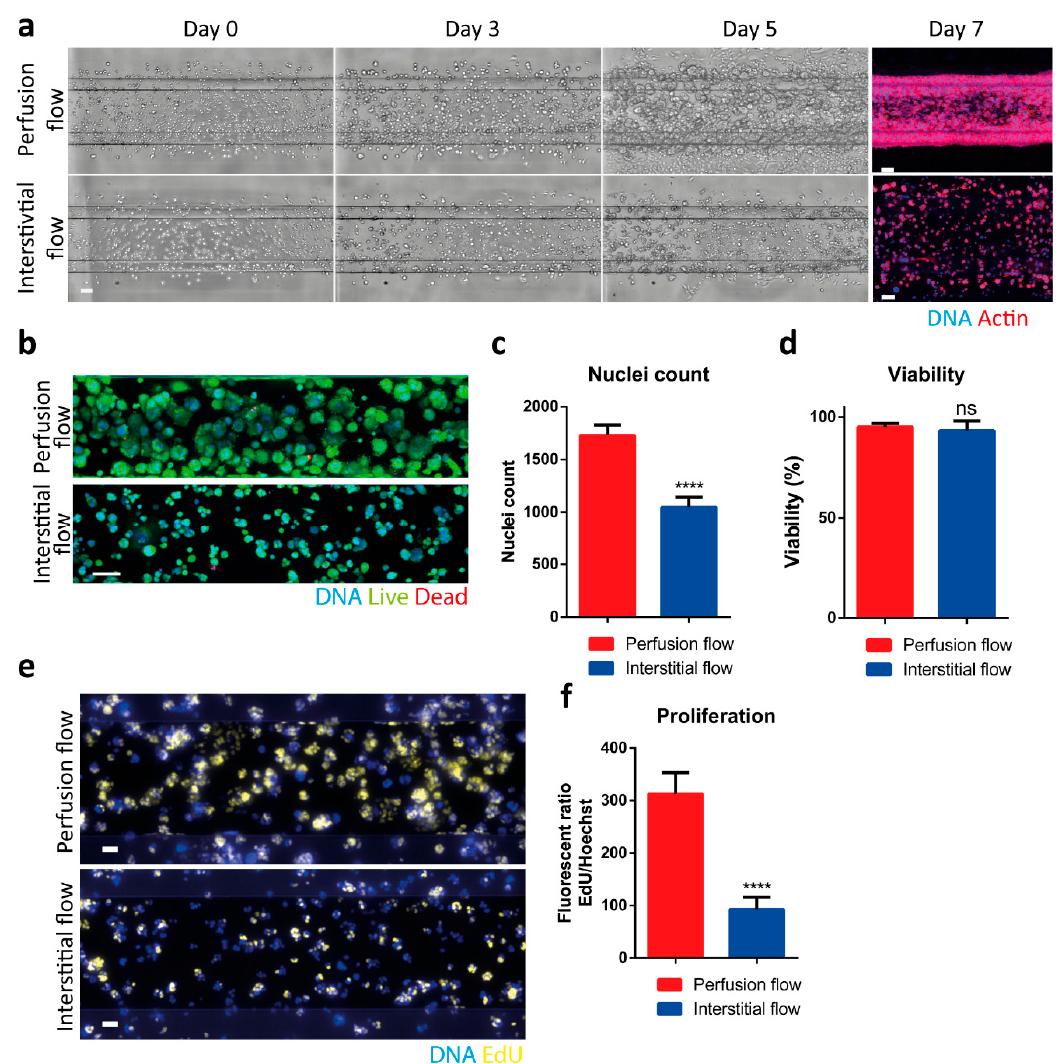
Figure 2. Interstitial flow has pronounced effects on the S2-028 cells. ( a ) A total of 2.5 million S2-028 cells/mL were loaded in the 3-lane OrganoPlate and cultured under different flow conditions; ( right ) immunofluorescent visualization for actin (red) and DNA (Hoechst, blue) of the ECM compartment at day 7. A maximum projection of z-stacks is shown. ( b ) Live (Calcein-AM, green) / dead (propidium Iodide, red) staining at day 5. Representative images are shown for both flow types. ( c – d ) Quantification of the number of nuclei and viability ( n = 10 – 18 technical replicates). Bar plot represents average + SD. ( e – f ) The proliferation rate of the S2-028 cell line was assessed with an EdU (yellow) incorporation assay, determining average EdU fluorescence, normalized for the amount of DNA using the Hoechst (blue) signal ( n = 14 technical replicates, bar plot represents average + SD). Scale bar in Figure a – c is 100 µm, e is 50 µm. Statistical test: unpaired two-tailed t-test (ns = not significant, **** p < 0.0001).